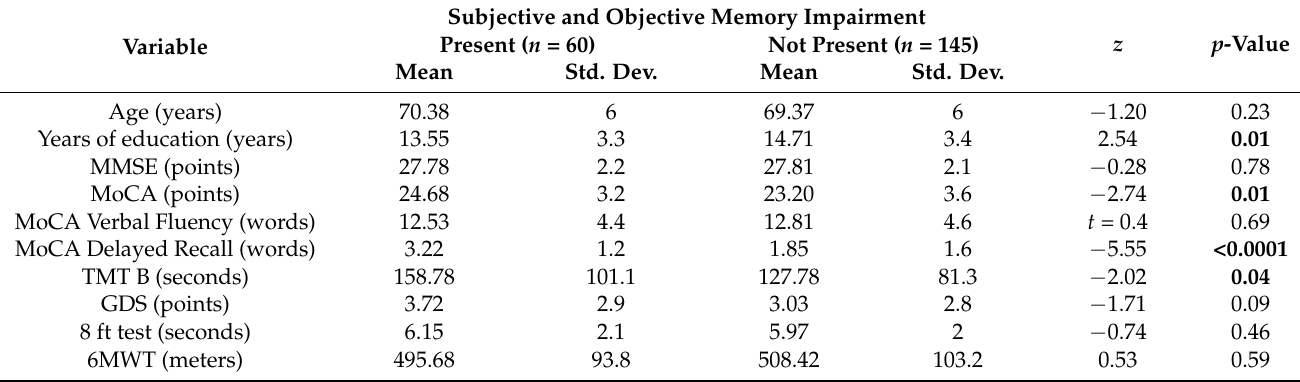
Table 4. Difference in variables measured in the baseline between subgroups with SMC present vs. non-present after two years.